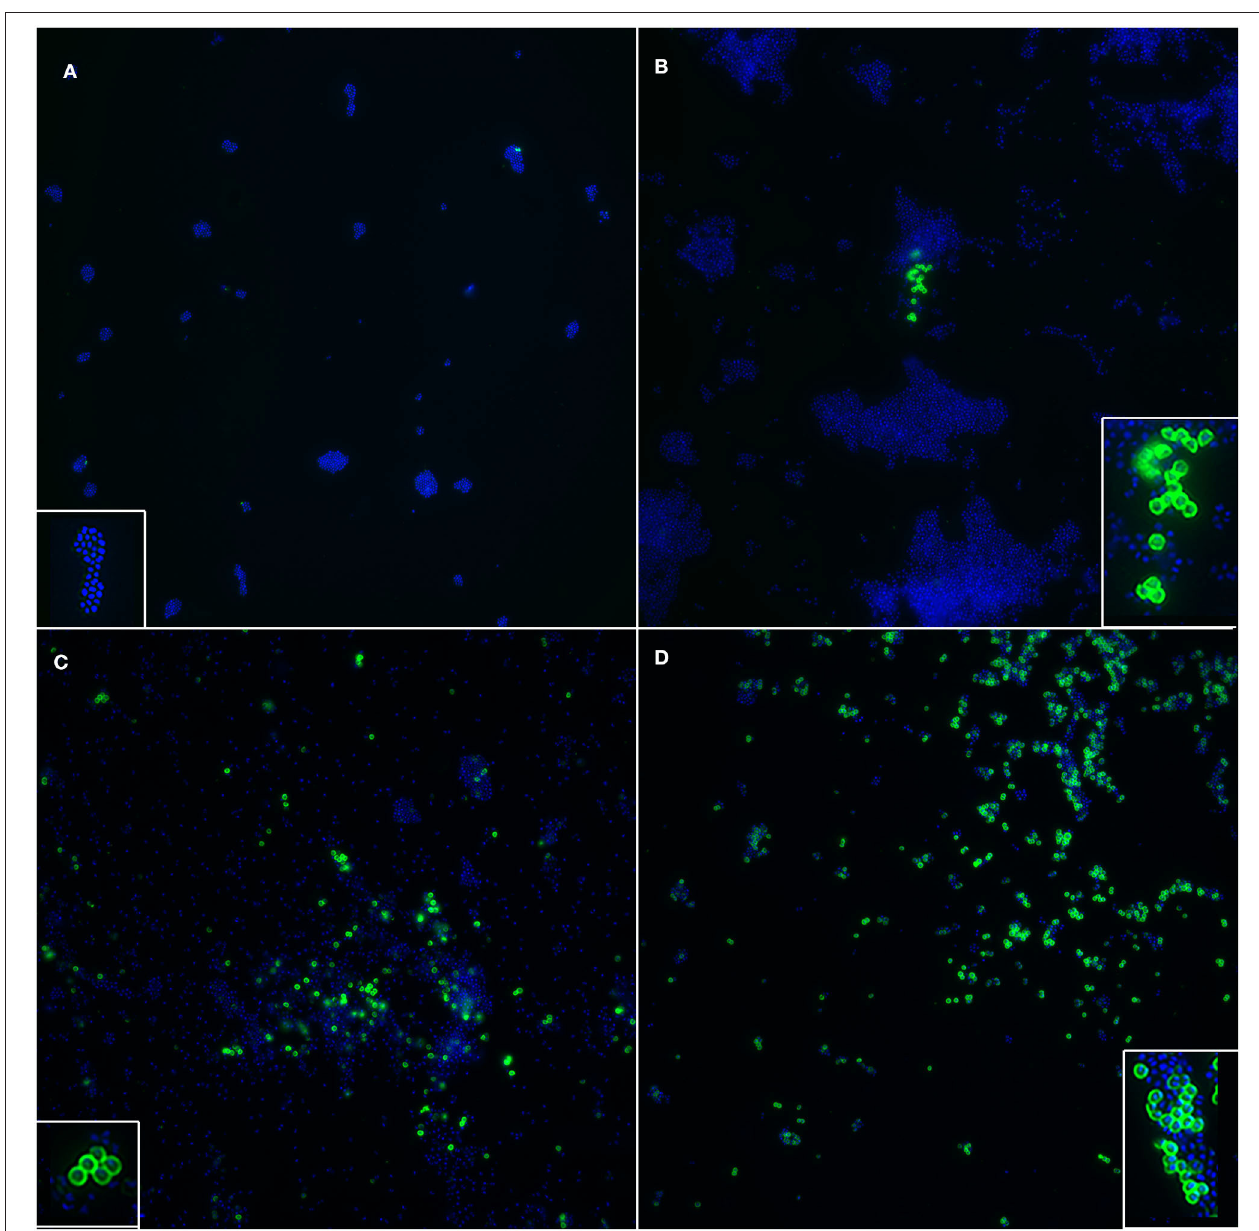
FIGURE 2 | Immunofluorescence targeting PBP2a protein in SP, showing isolate-dependent variability in PBP2a expression level. (A) Negative control. Insert: a cluster of SP whose cell walls stained negative and only the nucleoid can be seen (blue). (B) A cluster of SP clearly expressing PBP2a protein (green) is shown; the majority of SP does not express the protein. Insert: a magnification of cell walls staining positive, with a well-defined membranous pattern. (C) Several SP, both in clusters and sparse, stained positive, while a large proportion of them is negative. Insert: bacteria with cell wall expression of PBP2a protein. (D) Most of the SP showed positive cell walls. Insert: a cluster of bacteria where most of them have distinct positivity of the cell walls, together with other negative bacteria where only the nucleoid is stained. Blue: DAPI; Green: Alexa Fluor ® 488.